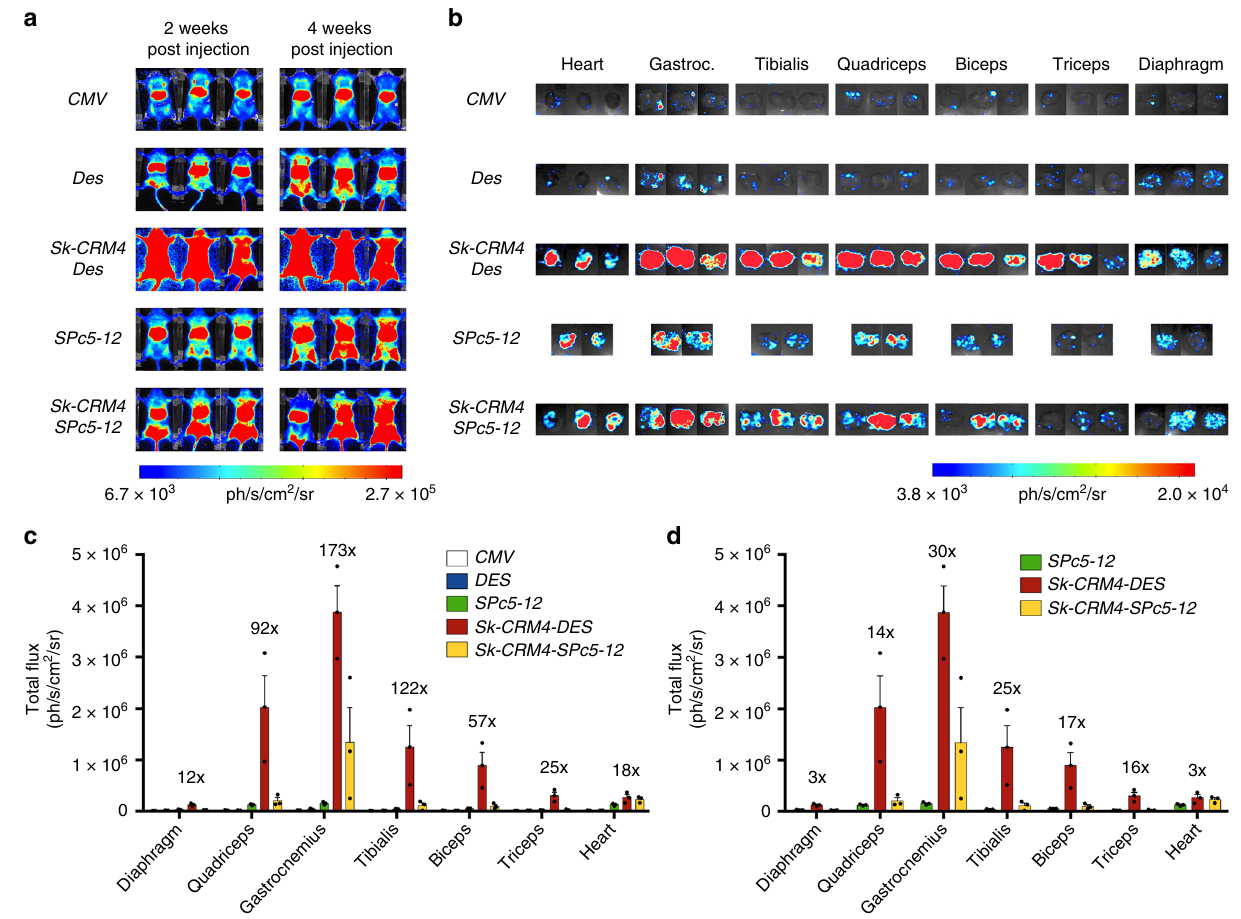
Fig. 4 Comparison of Sk-CRM /promoter combinations with conventional promoters. a In vivo bioluminescence imaging at week 2 and week 4 post vector injection in adult CB17/IcrTac/Prkdc scid mice intravenously injected with the different scAAV9 luciferase vectors containing the different promoters ( CMV, Des, Sk-CRM4/Des, SPc5-12, Sk-CRM4/SPc 5-12 ) at a dose of 1 × 10 10 vg per mouse. A color scale from 6.7e + 03 (blue) ph/s/cm 2 /sr to 2.7e + 05 (red) ph/s/cm 2 /sr was shown. Photon emission was measured dynamically during 7 min. b Ex vivo bioluminescence imaging of individual tissues harvested at 6-week post vector injection was represented on a color scale with luciferase intensities ranging from 3.80e + 03 (blue) ph/s/cm 2 /sr to 2.02e + 04 (red) ph/s/cm 2 /sr. The bioluminescence signal was quanti fi ed for 5 min. c Luciferase expression from the individual tissues was measured as total fl ux, expressed in ph/s/cm 2 /sr. The fold-difference of the total fl ux of the SkCRM4/Des chimeric promoter was indicated relative to the CMV promoter (without any Sk-CRM) . The luciferase signal were showed as mean + s.e.m. ( n =